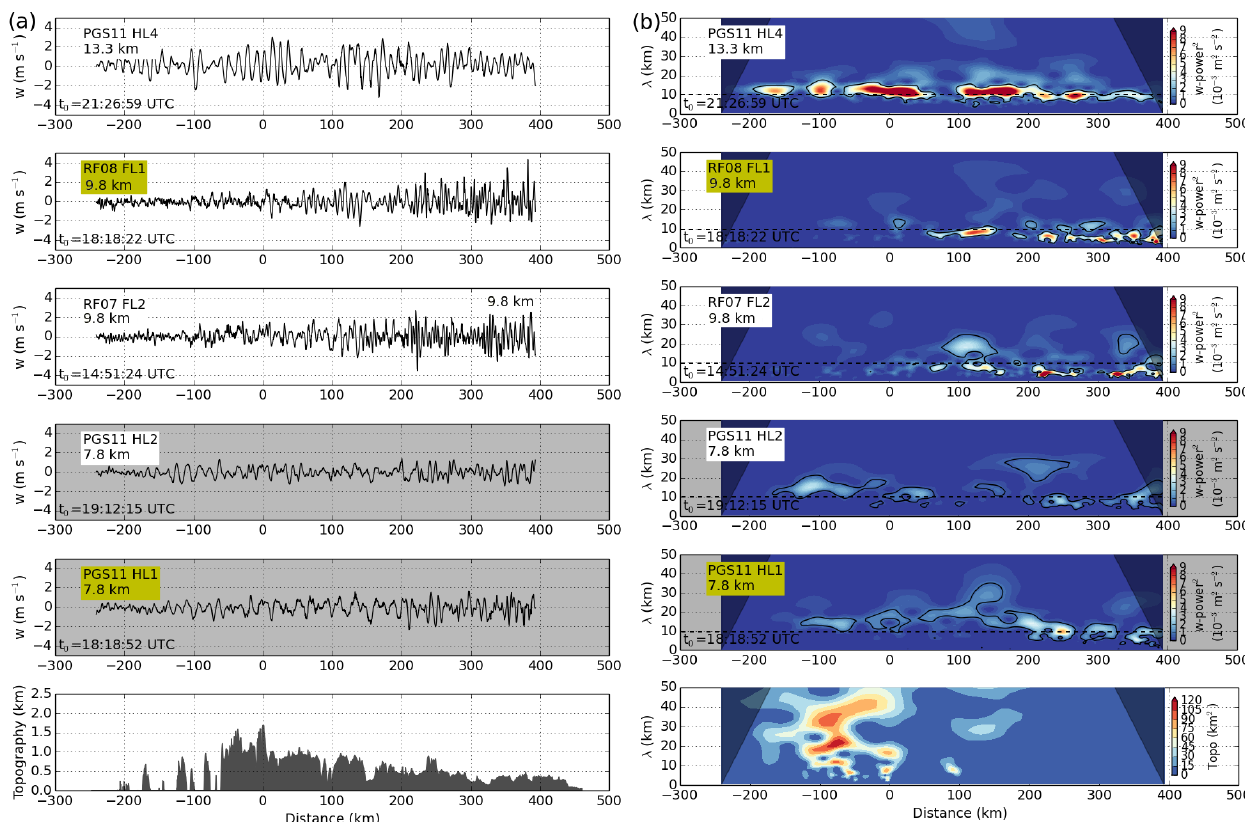
Figure 6. Cross-mountain flight legs of Falcon and HALO for panel (a) in situ vertical wind and topography and (b) corresponding wavelets with the horizontal wavelength given on the y axis. The dashed horizontal line marks 10km horizontal wavelength that separates short and intermediate scale waves. Black contour lines mark regions significant at the 95% confidence level. The cone of influence is shaded in grey. Flight legs located below the tropopause (see labelled mean flight altitudes) are marked with grey background colour. Time t 0 indicates when the aircraft was located at X 0 (see Fig. 1) and shows that PGS11 HL1 and RF08 FL1 (labelled with yellow boxes) took place nearly at the same time (HALO was flying 30s behind